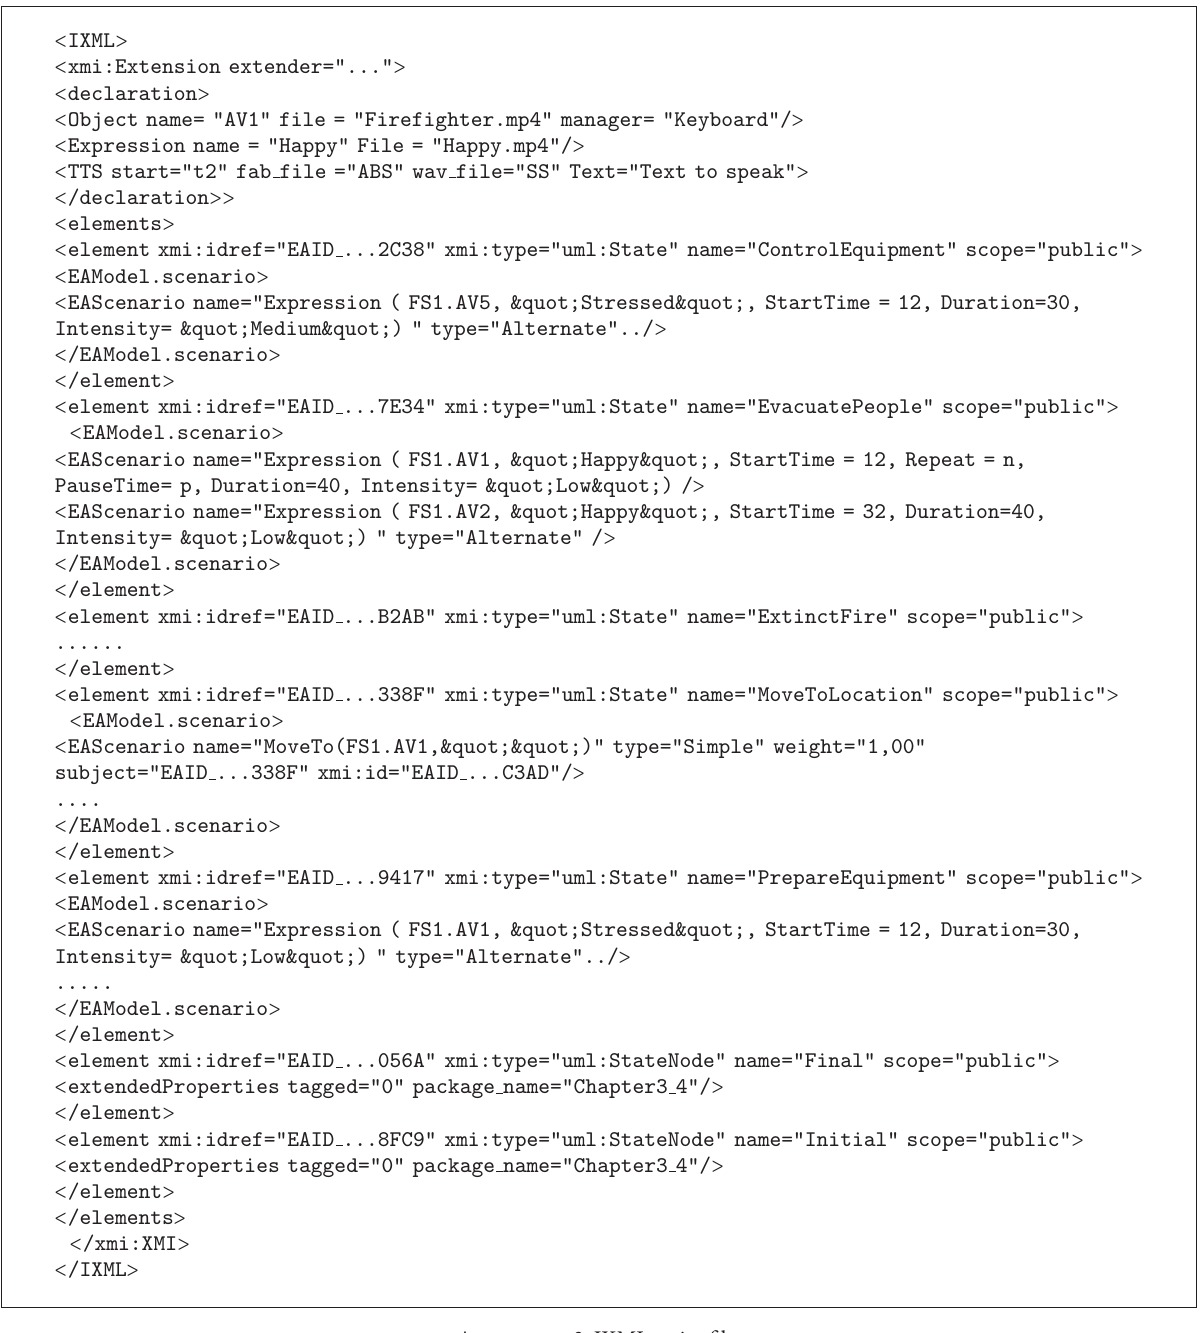
Algorithm 2: IXML script